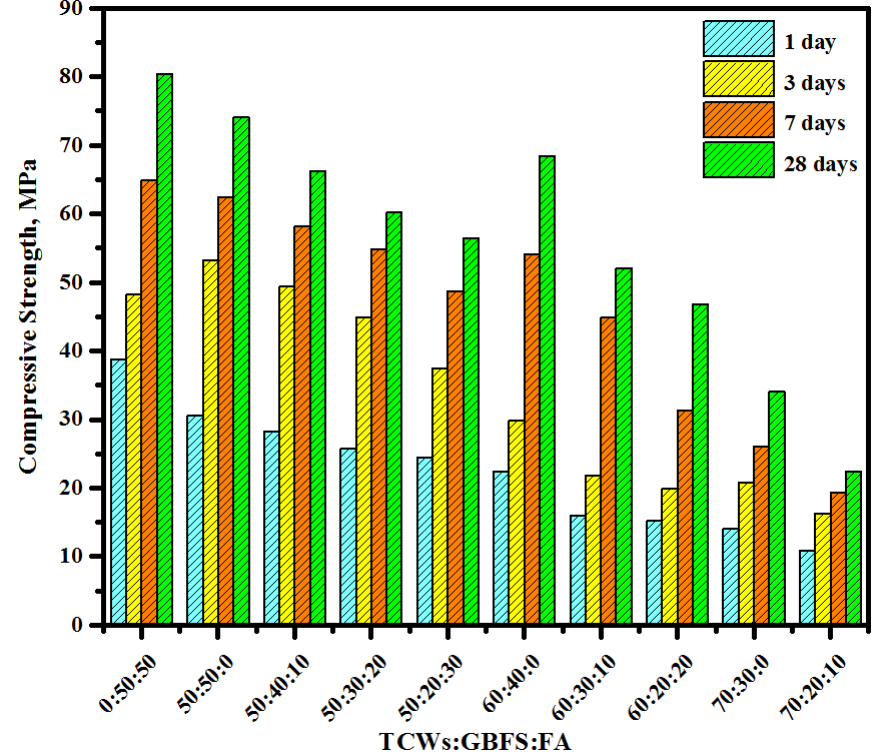
Figure 6. High volume TCWs-content-dependent compressive strength of GPMs.